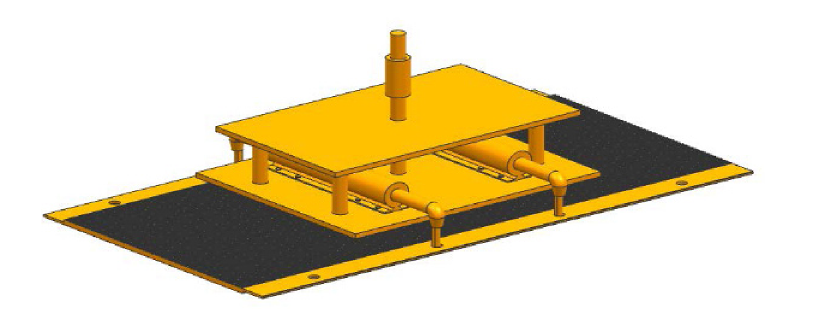
Fig. 4. The structural shape of the